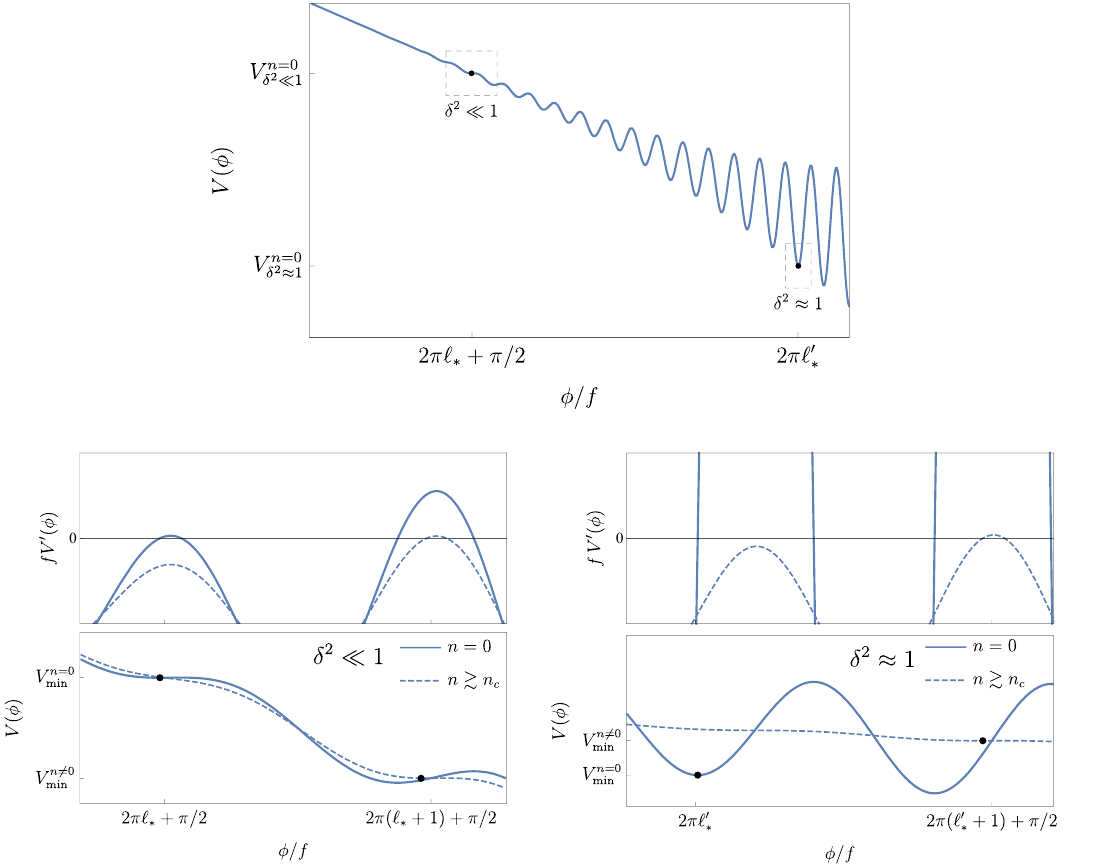
Figure 1 . Global view of the relaxion potential (upper panel) and zoomed in regions with shallow (lower left) and deep (lower right) minima. Also plotted in the lower panels the in-density potential for n slightly larger than critical (dashed). The upper sub-panels show the derivative of the potential, both for n = 0 and n & n c . The first minima at finite density are always